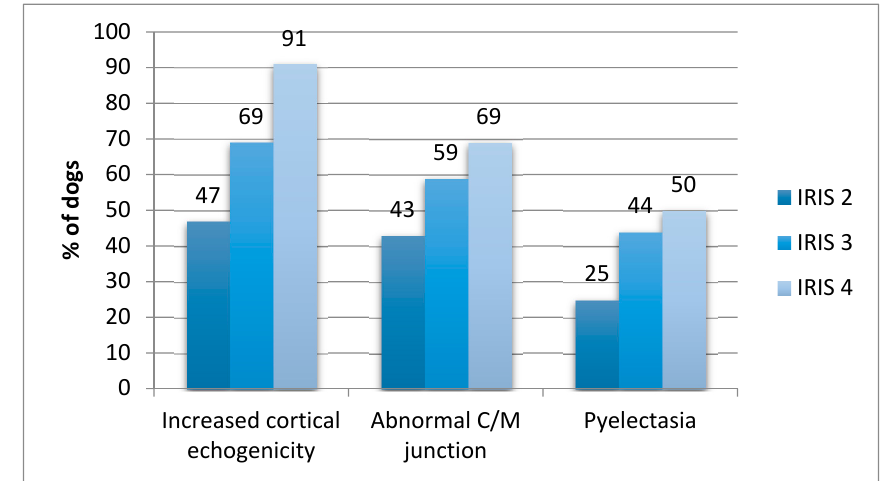
Figure 2. Most prevalent US abnormalities at different CKD IRIS stages.